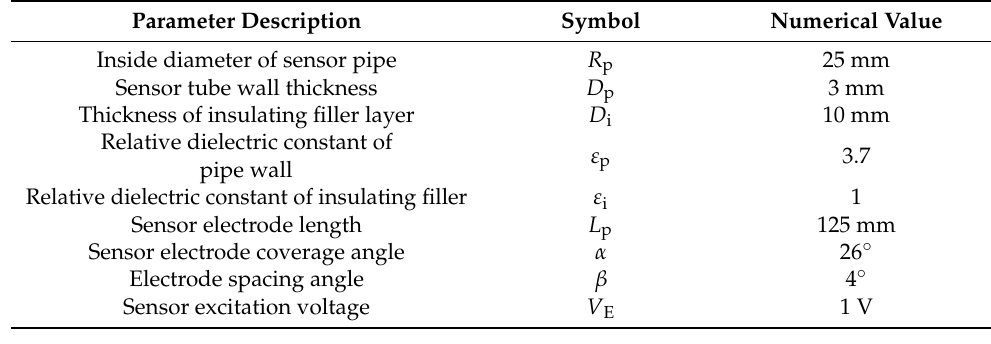
Table 1. Parameter settings of fully uniform ECT sensor simulation model.